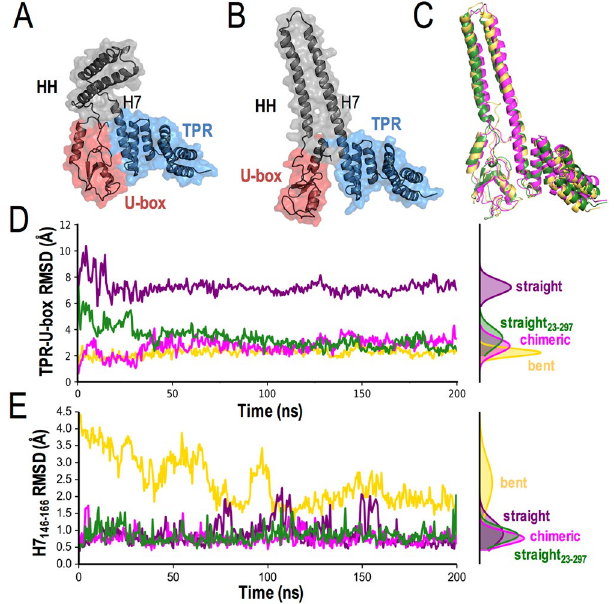
Figure 2. Chimera of extended helix 7 and TPR/U-box complex is more stable than bent or straight CHIP monomers. Structures of ( A ) bent and ( B ) straight monomers from the CHIP crystal structure. The bent monomer has helix 7 (H7) between HH and TPR domains broken, and TPR/U-box bound with the E2 binding site buried. The straight monomer has an extended H7, and the TPR and U-box are separated by the C-terminus to expose an E2 binding site. ( C ) Structural alignments of MDS snapshots of bent monomer (gold) and truncated straight 23–297 monomer (missing last six C-terminal residues) (forest) to chimeric monomer (magenta) yield an overall backbone RMSD of 2.7 and 3.3 Å. Backbone RMSD relative to the crystal structure of ( D ) the TPR/U-box complex and ( E ) the H7 between residues 146–166 as a function of time. The bent, straight, chimeric and truncated straight 23–297 RMSD distributions are shown in gold, purple, magenta and forest,